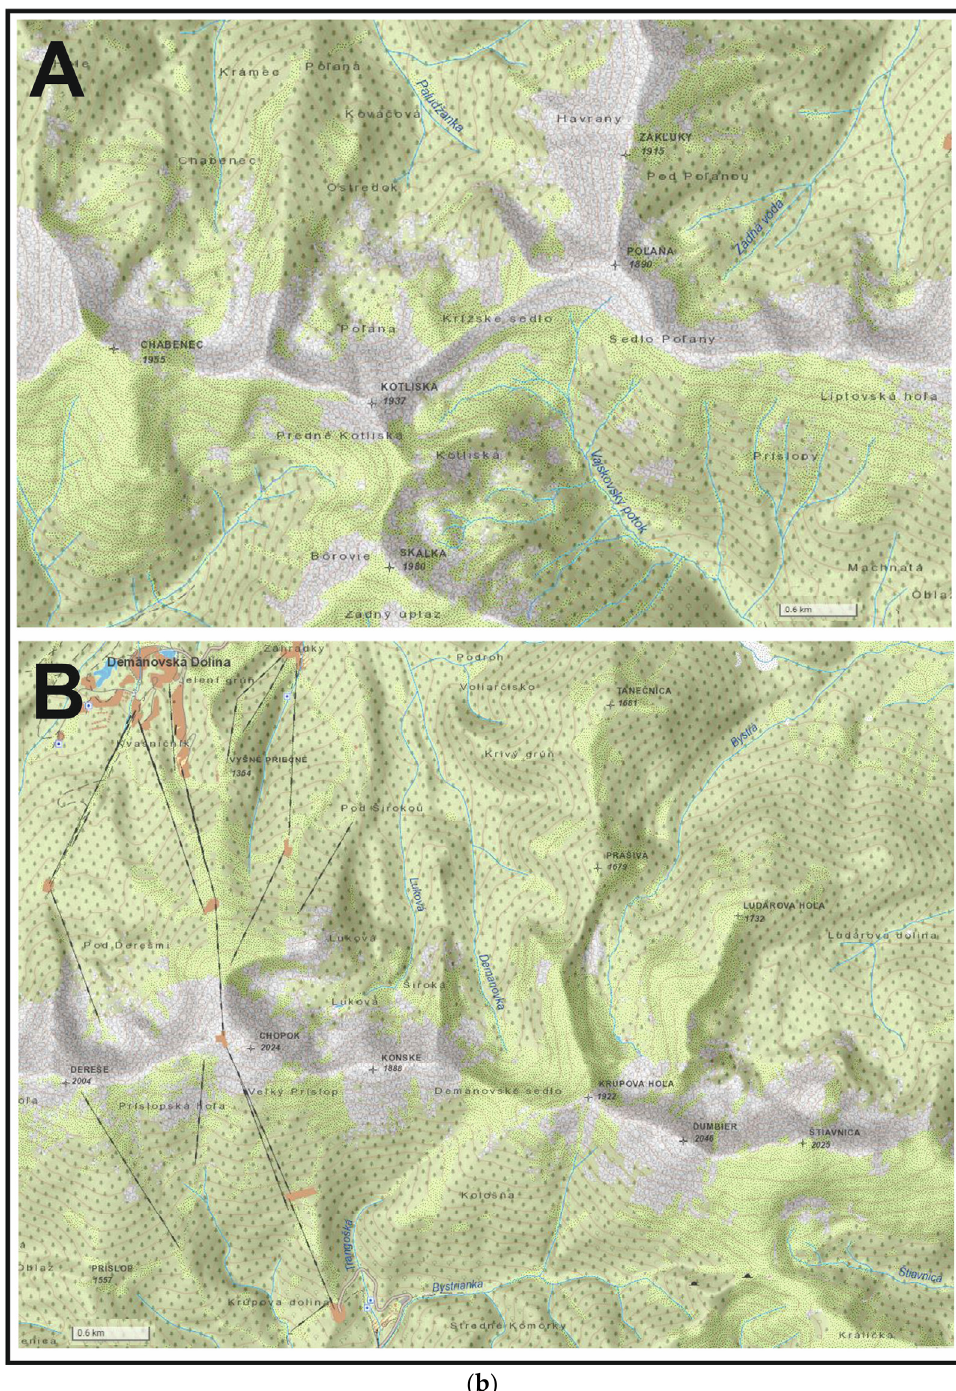
Figure 1. ( a ) Location and delimitation of the studied area of the Ď umbier Tatras mountain ranges within Slovakia and Europe (source: Esri; National atlas of Slovak Republic, 2002). ( b ) Main Ď umbier Tatras mountain range—central part of studied area (west part A, east part B). source: ZB Gis.